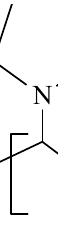
Figure 2. The structure of PVP.